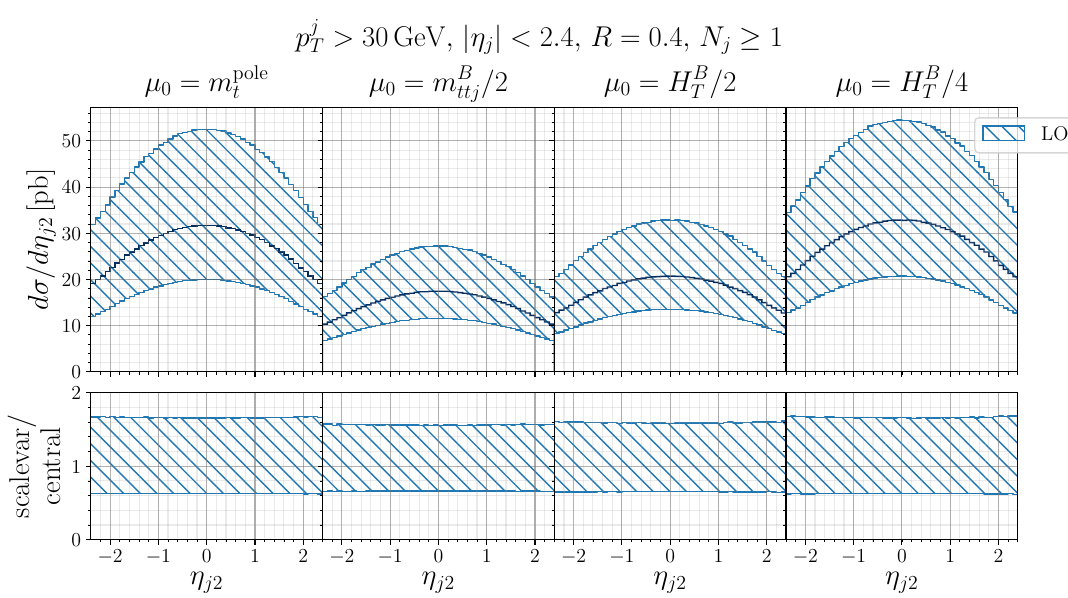
Figure 16 . Same as in figure 7, but for the η j distribution. The content of the panels reflect the 2 fact that the second jet appears for the first time in NLO calculations and, therefore, the accuracy of the predictions for it is limited to